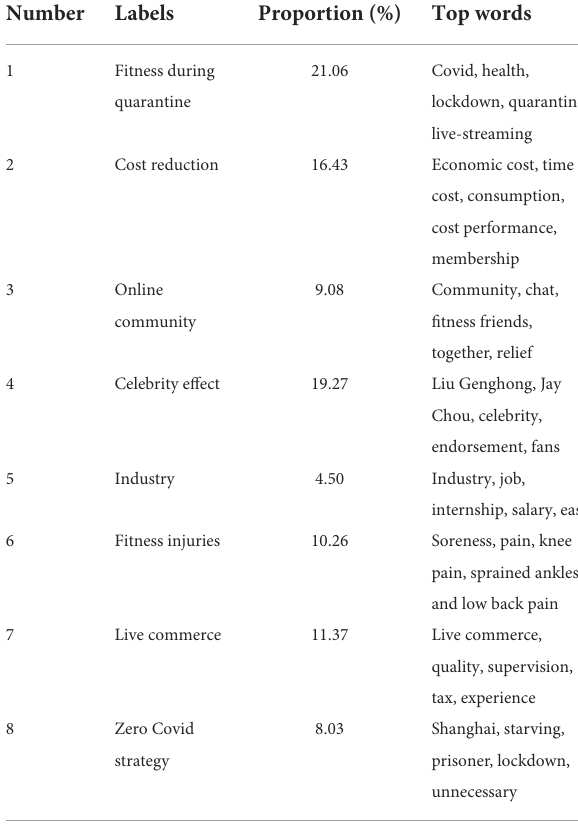
TABLE 1 Topics generated by STM. TABLE 2 Most representative Weibo texts and topic label